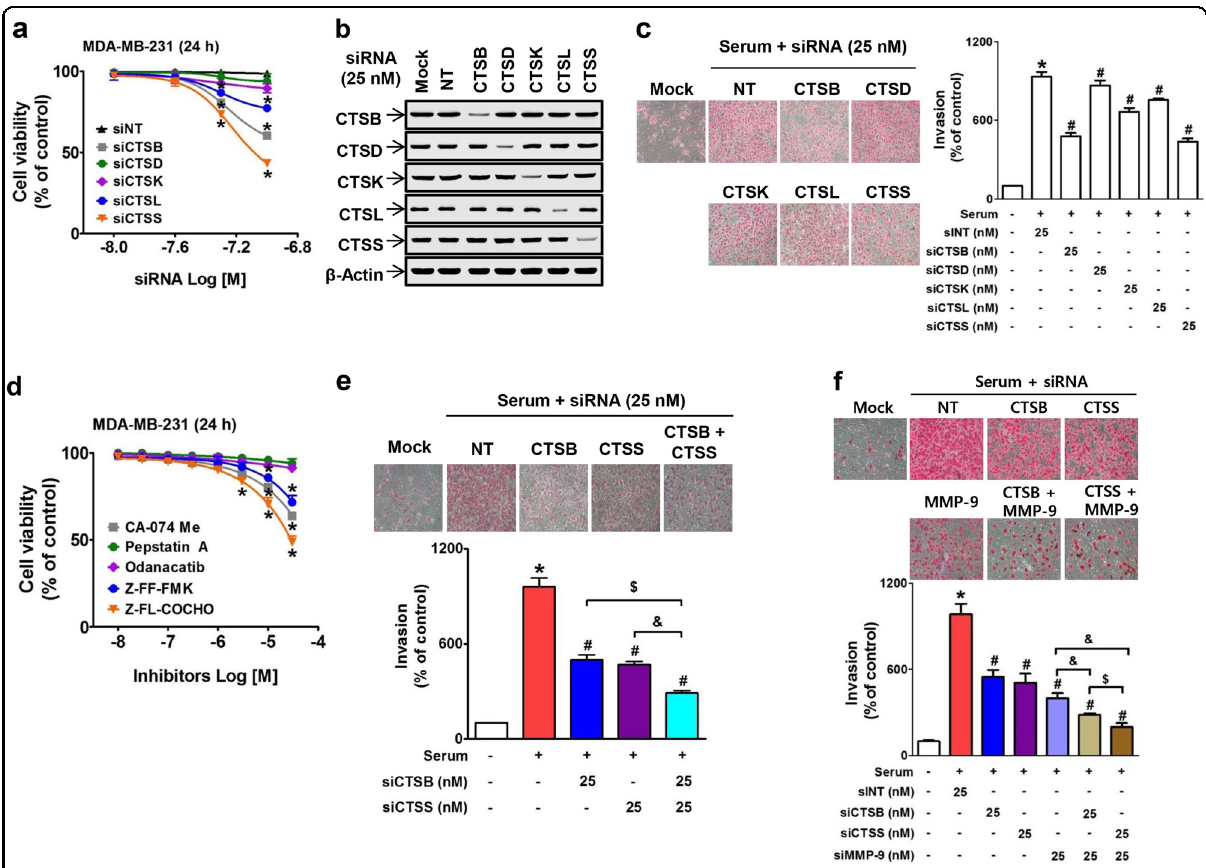
Fig. 2 Dual roles of CTSS in viability and invasion of MDA-MB-231 breast cancer cells. a Cell viability of MDA-MB-231 cells transfected with different types of CTS siRNAs. b Transfection ef fi ciency measurement of speci fi c CTS siRNA (25 nM) in MDA-MB-231 cells. c , e Cells were transfected with 25 nM of the indicated siRNAs, and invasion assays were performed as described in the Methods section. The photos are representative of three independent experiments, and the bar graph indicates the mean ± S.E.M. * P < 0.05 compared to control. # P < 0.05 compared to the serum-treated group. $ P < 0.05 compared to CTSB siRNA-transfected group. & P < 0.05 compared to the CTSS siRNA-transfected group. d Cell viability of MDA-MB-231 cells treated with speci fi c CTS inhibitors. f MDA-MB-231 cells were treated with siRNAs of each CTS or MMP-9, and invasion assays were performed. The bar-diagram represents the quantitation of data. * P < 0.05 compared to the control. # P < 0.05 compared to the serum-treated group. & P < 0.05 compared to the MMP-9-siRNA-treated group. $ P < 0.05 compared to the CTSB-siRNA- and MMP-9-siRNA-treated